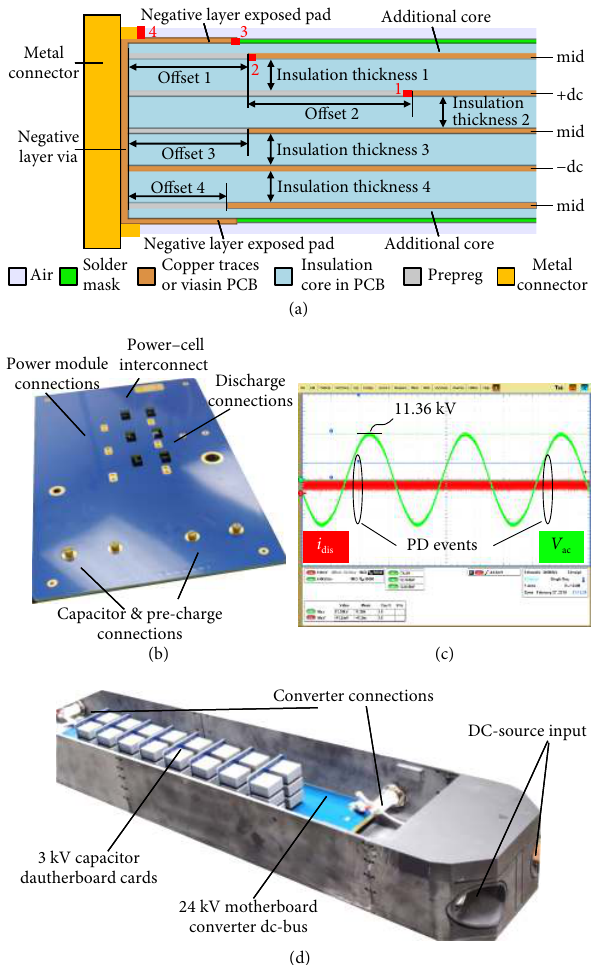
Fig. 6 (a) 2D section view of multi-layer PCB bus for MV converters. (b) De- veloped 6 kV PCB-based bus. (c) PDIV assessment of PCB-based dc-bus pro- totype. (d) Converter-level PCB-based dc-bus assembly.